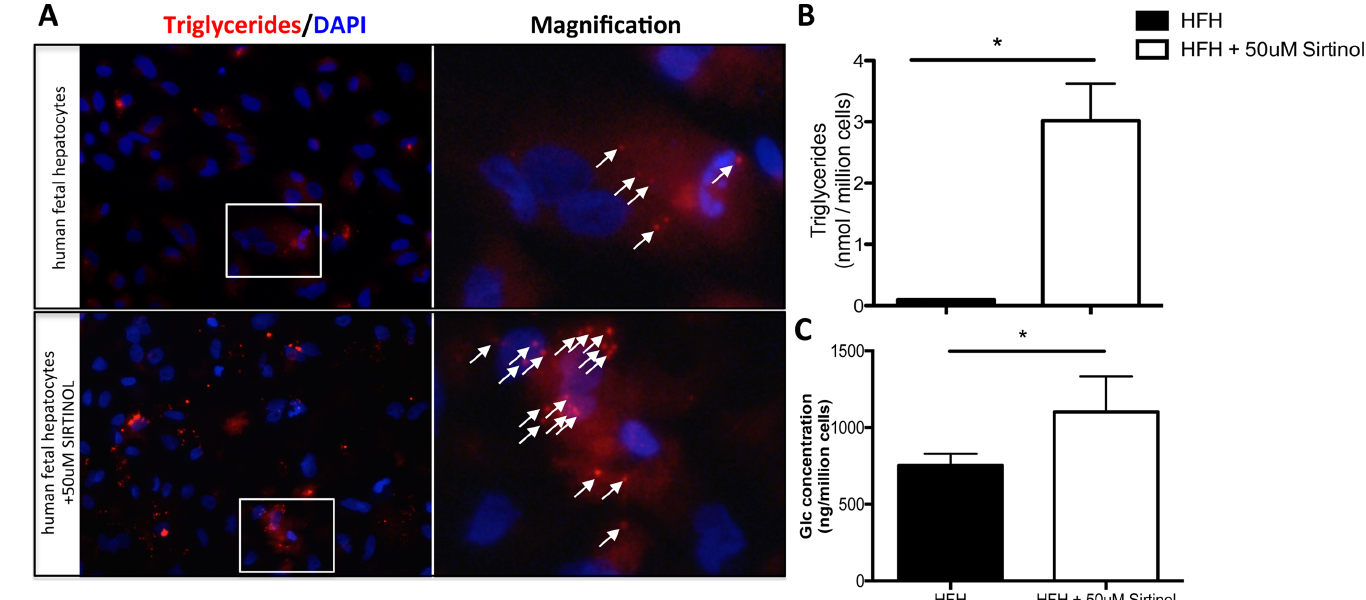
Fig 2. Lipids and glucose levels in human fetal hepatocytes after Sirt1 inhibition. (A) Fluorescent staining of lipids (red droplets, white arrow) inside human fetal hepatocytes (HFH) with or without 50uM Sirtinol for 3 days (20x). (B) Triglycerides quantification of human fetal hepatocytes with or without +50uM Sirtinol for 3 days analyzed by a colorimetric assay. (C) Glucose concentration between normal HFH and HFH +50uM Sirtinol for 3 days. (n (cid:1) 7/group; * , P < .05).